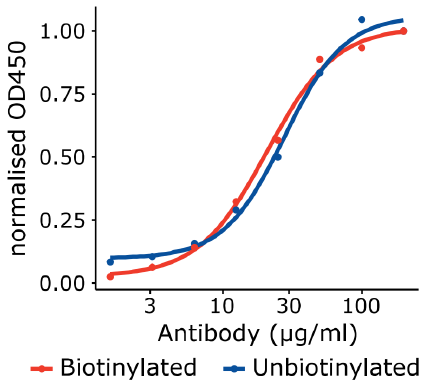
Figure 2. The impact of biotinylation upon the antigenicity of recombinant